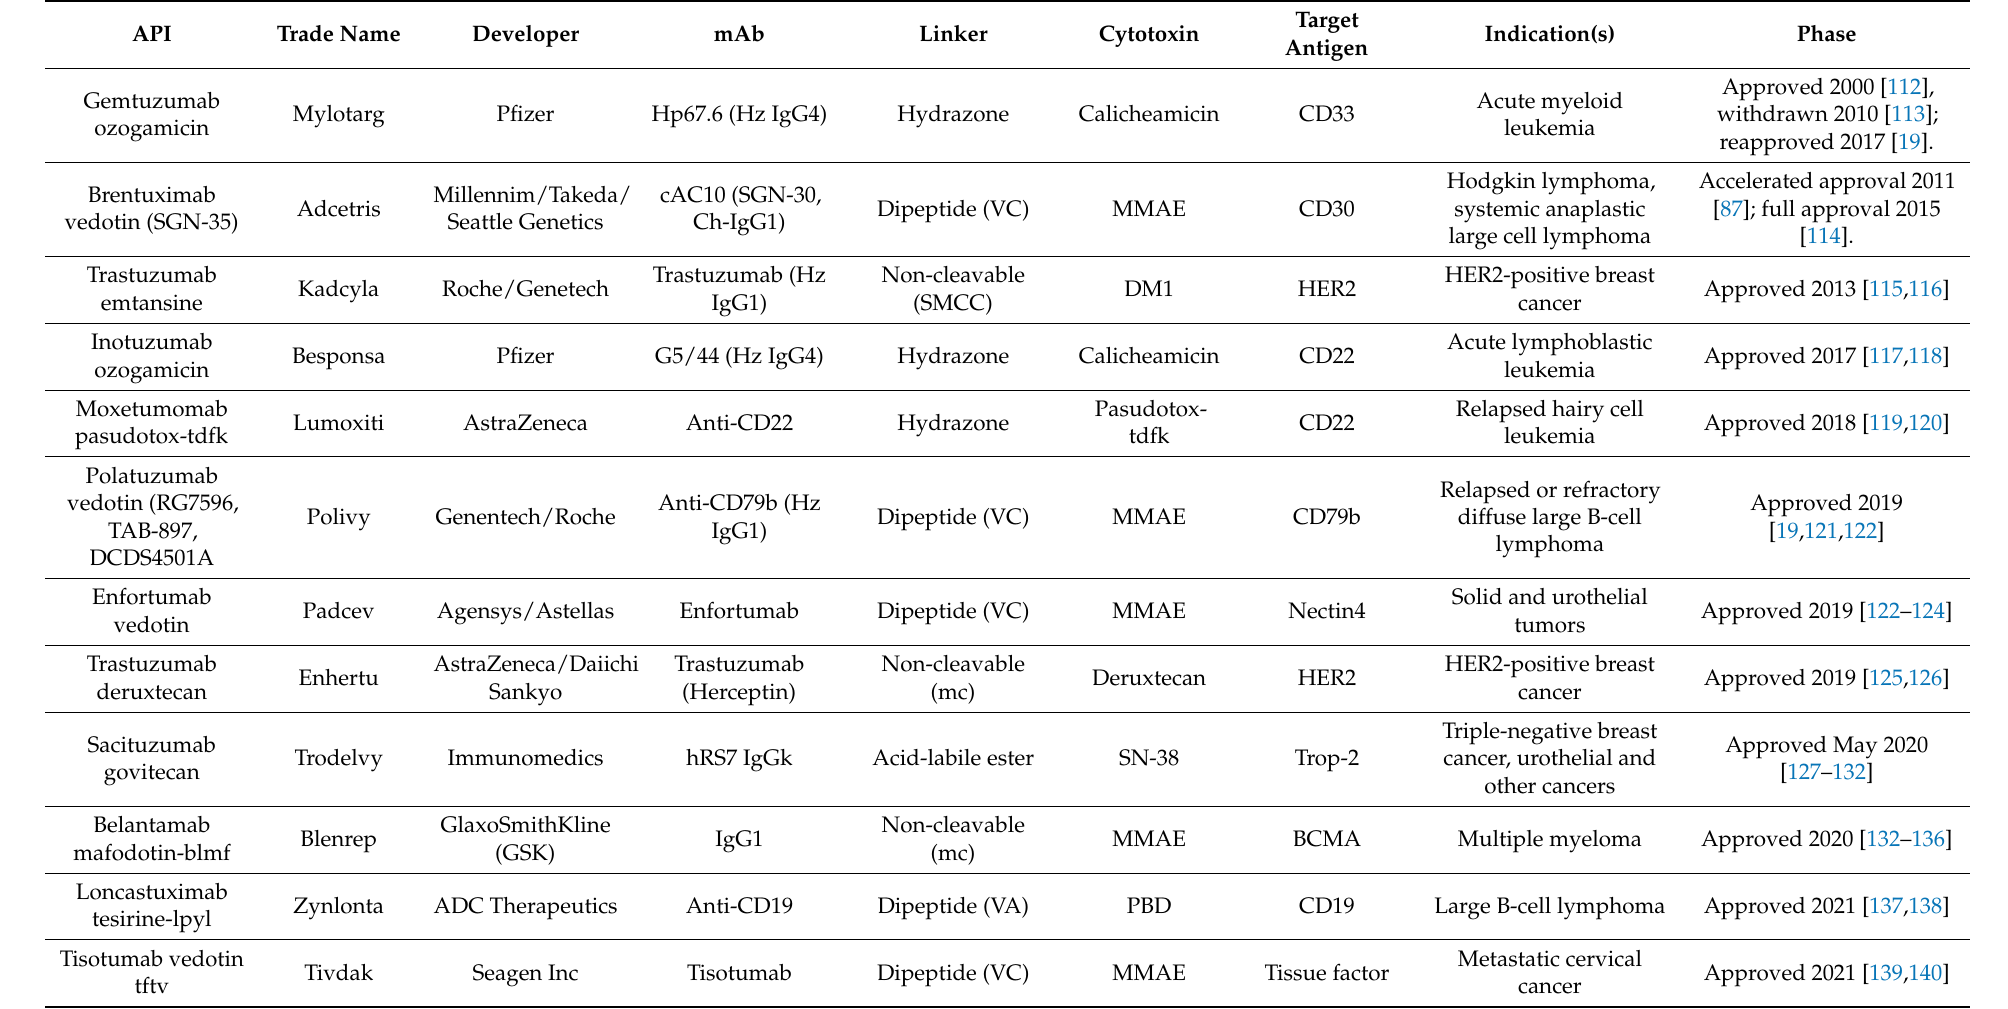
Table 2. Antibody-drug conjugates